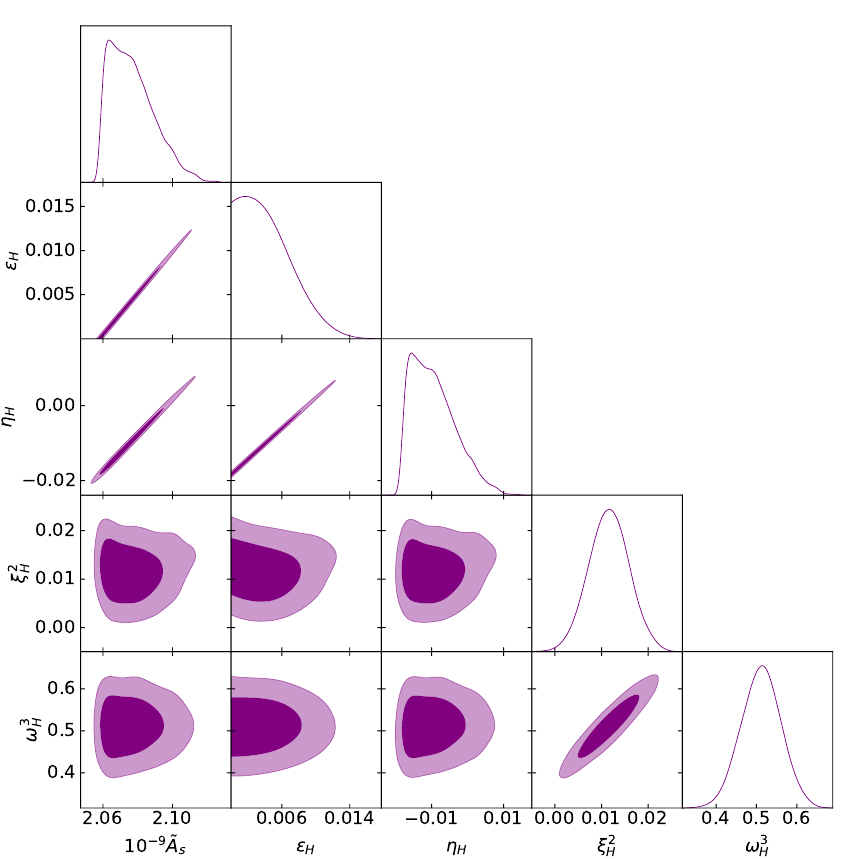
Figure 9: Marginalized 68% and 95% CL contours from the 5-dimensional likelihood of the slow-roll parameters in Eq.(14). We combine the 2018 Planck results with SKA projections assuming 10000 hrs observation time.